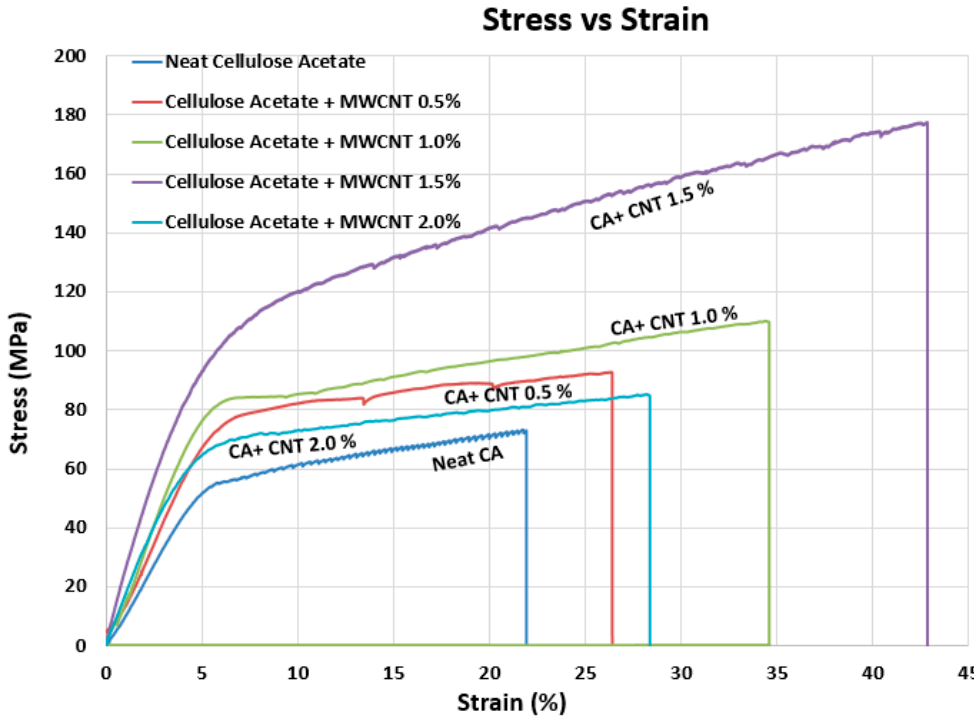
Figure 3. Representative tensile test results bar chart of ( a ) neat cellulose acetate (CA) ( b ) 0.5% cellulose acetate-multi-walled carbon nanotube (CA-MWCNT) ( c ) 1.0% CA-MWCNT ( d ) 1.5% CA- MWCNT ( e ) 2.0% CA-MWCNT.